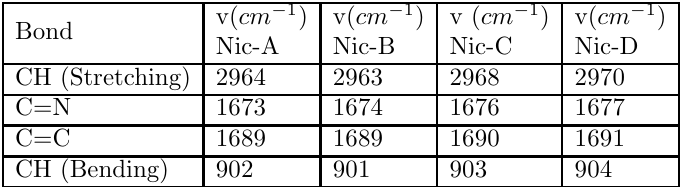
Table 3. Characteristics IR-absorption bands of samples